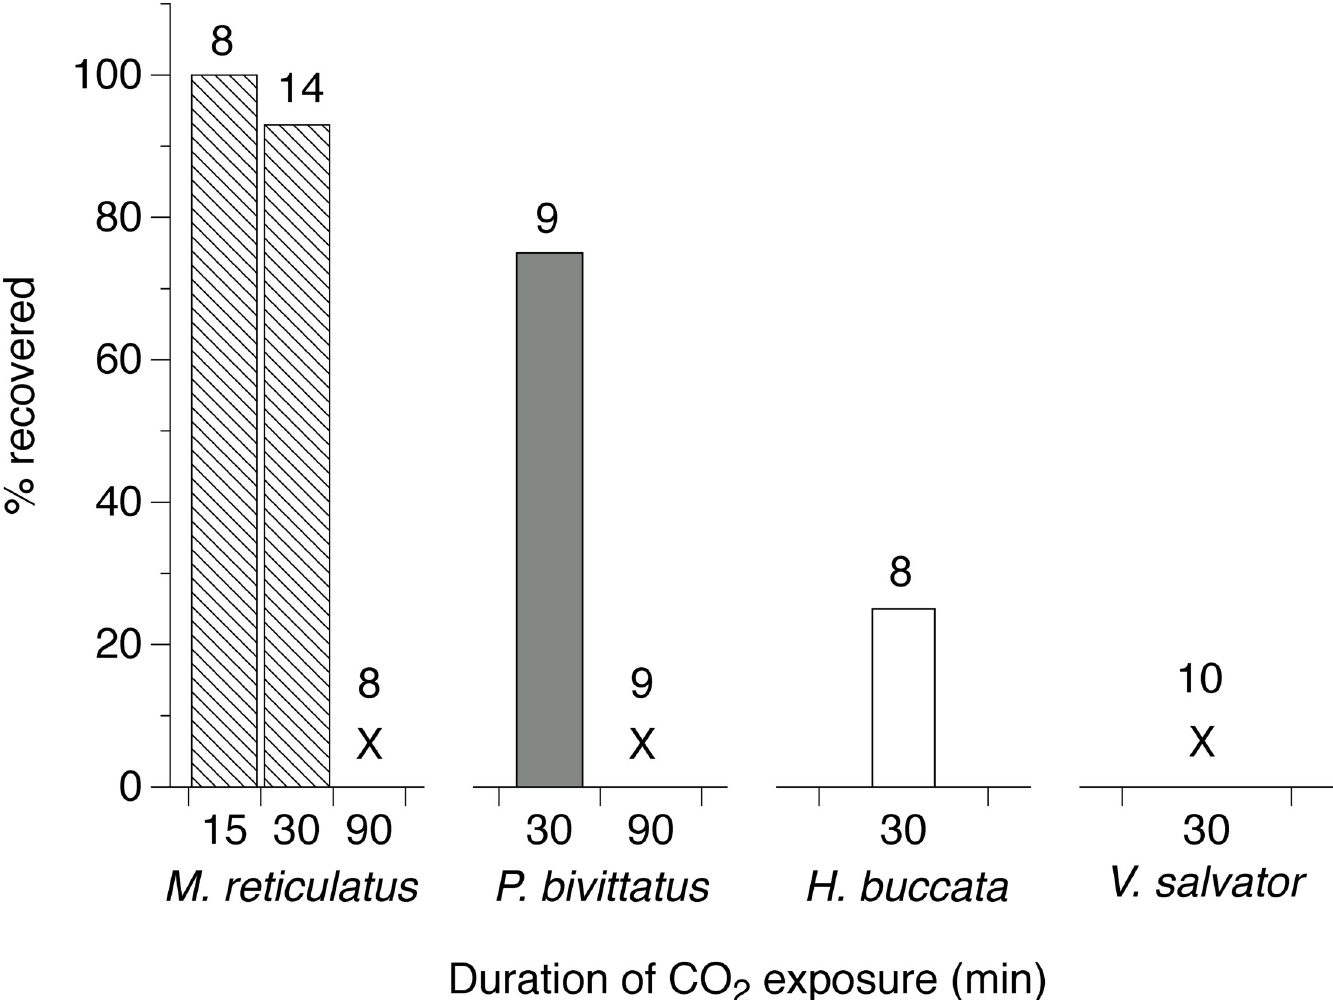
Fig 2. Percentage of Malayopython reticulatus , Python bivittatus , Homalopsis buccata , and Varanus salvator that recovered from different durations of CO 2 exposure. X denotes treatments where no individuals recovered from CO 2 exposure. Sample sizes appear above each column.